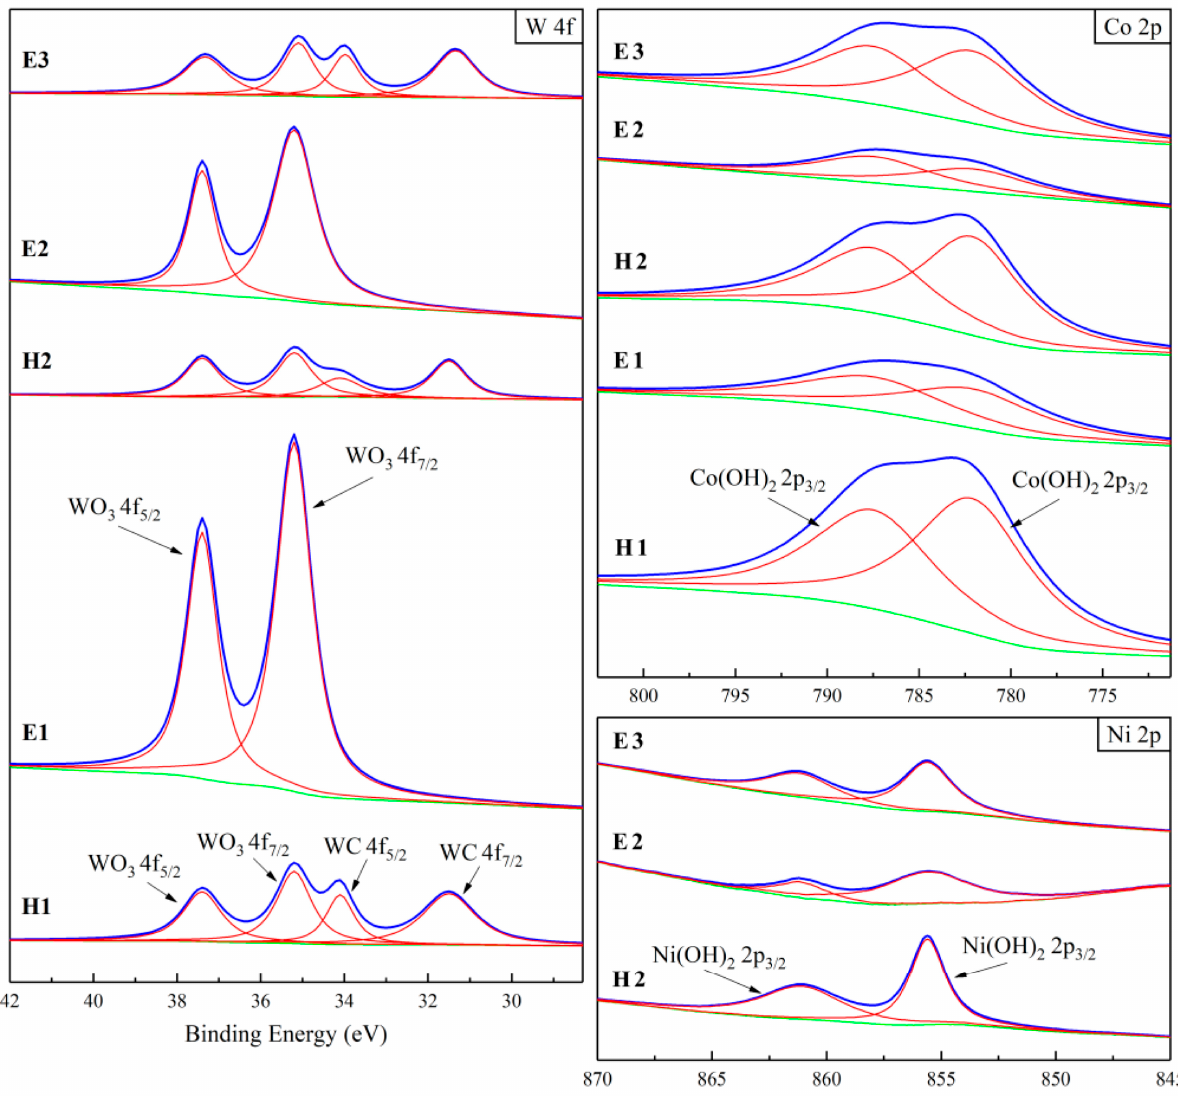
Figure 12. XPS result after corrosion.